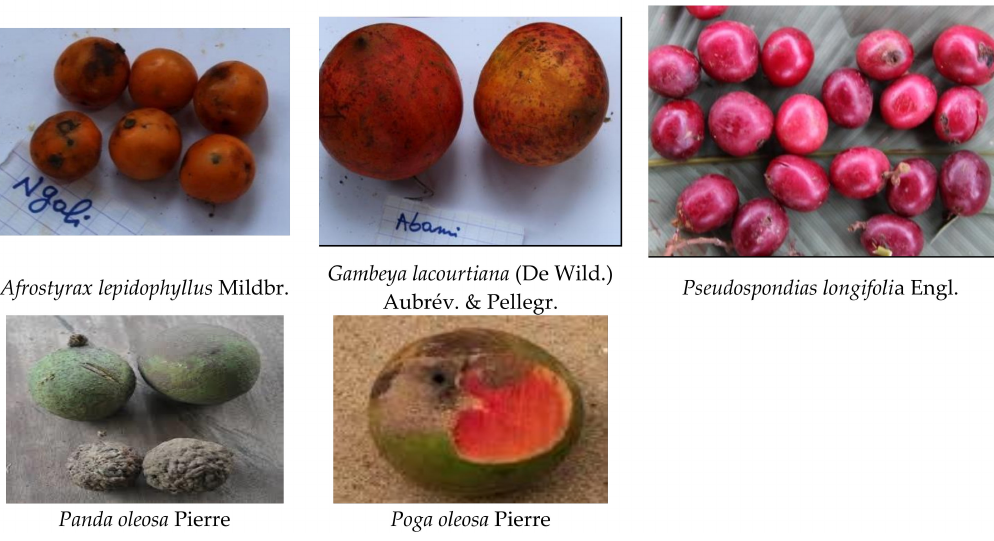
Figure 2. Fruits of A. lepidophyllus, G. lacourtiana, P. longifolia and nuts of P. oleosa and P.